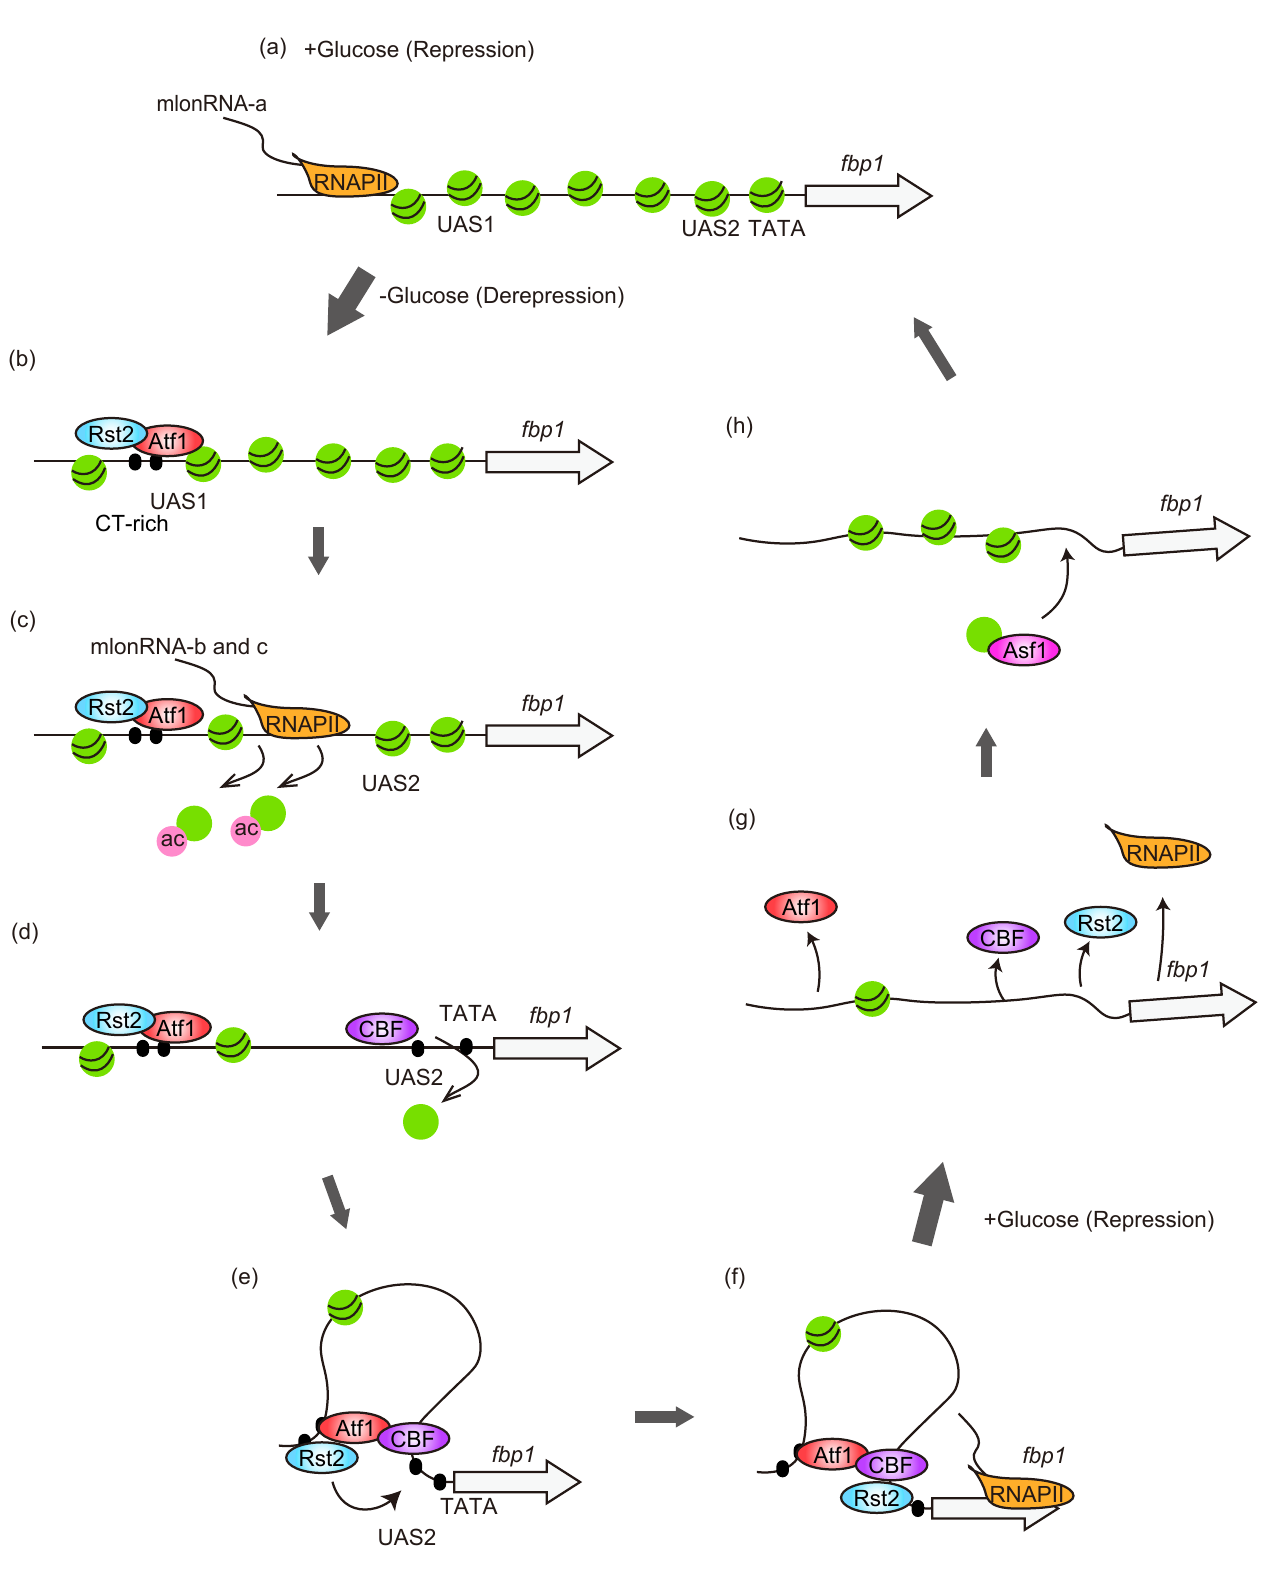
Figure 2. Dynamics of genome-chromatin architectures in fbp1 transcription regulation. ( a ) Repressive chromatin is assembled at the fbp1 promoter region in glucose rich condition. The longest